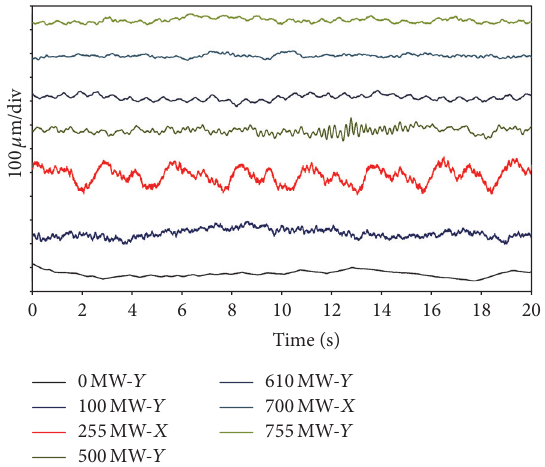
Figure 9: Bearing absolute vibrations at several generator loads (0 to 755 MW, from bottom to